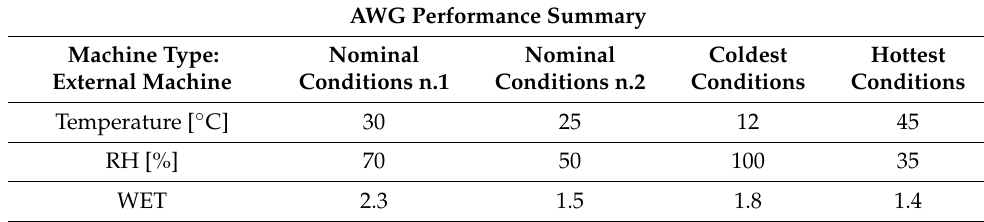
Table 8. WET (Water Energy Transformation) calculation results for an existing AWG machine in normalised conditions. AWG Performance Summary